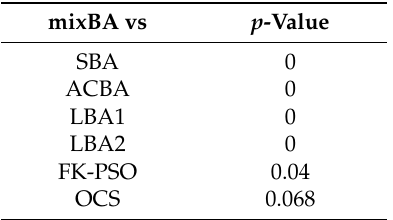
Table 6. Wilcoxon test for the seven